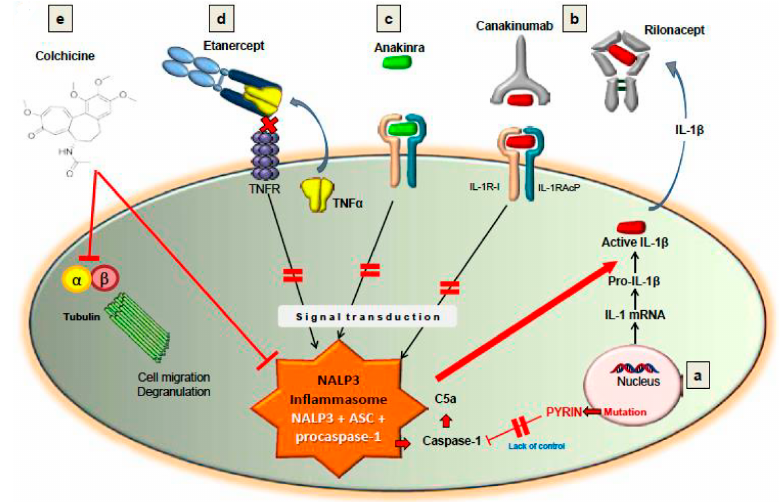
Figure 2. Treatment with cochicine, TNF blockade (e.g., Etanercept) or IL-1 β blockade (e.g., Anakinra, Canakinumab, Rilonacept) can lead to inactivation of the NALP3 inflammasome (Figure was originally published by Wang DQH et al. and cited with permission in this paper as reference [18]). Abbreviation: C5a, Complement protein fragment